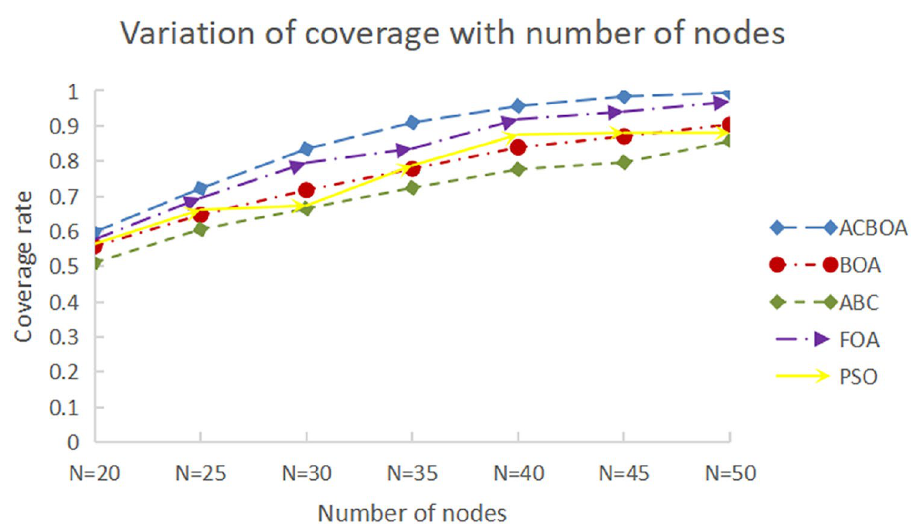
Figure 8. Variation of coverage with number of